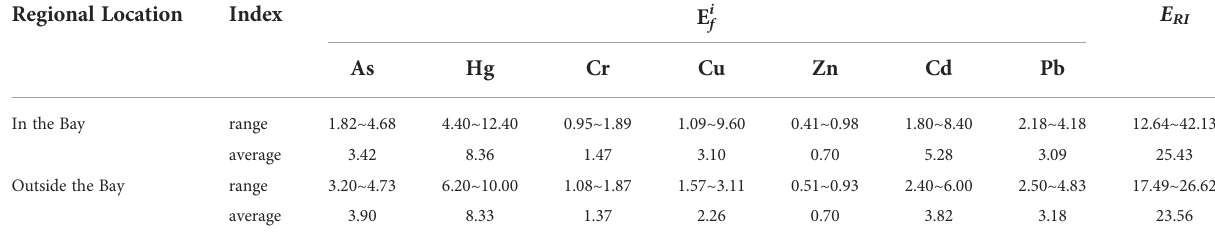
TABLE 4 Potential hazard indices of heavy metals in the sediments. Regional